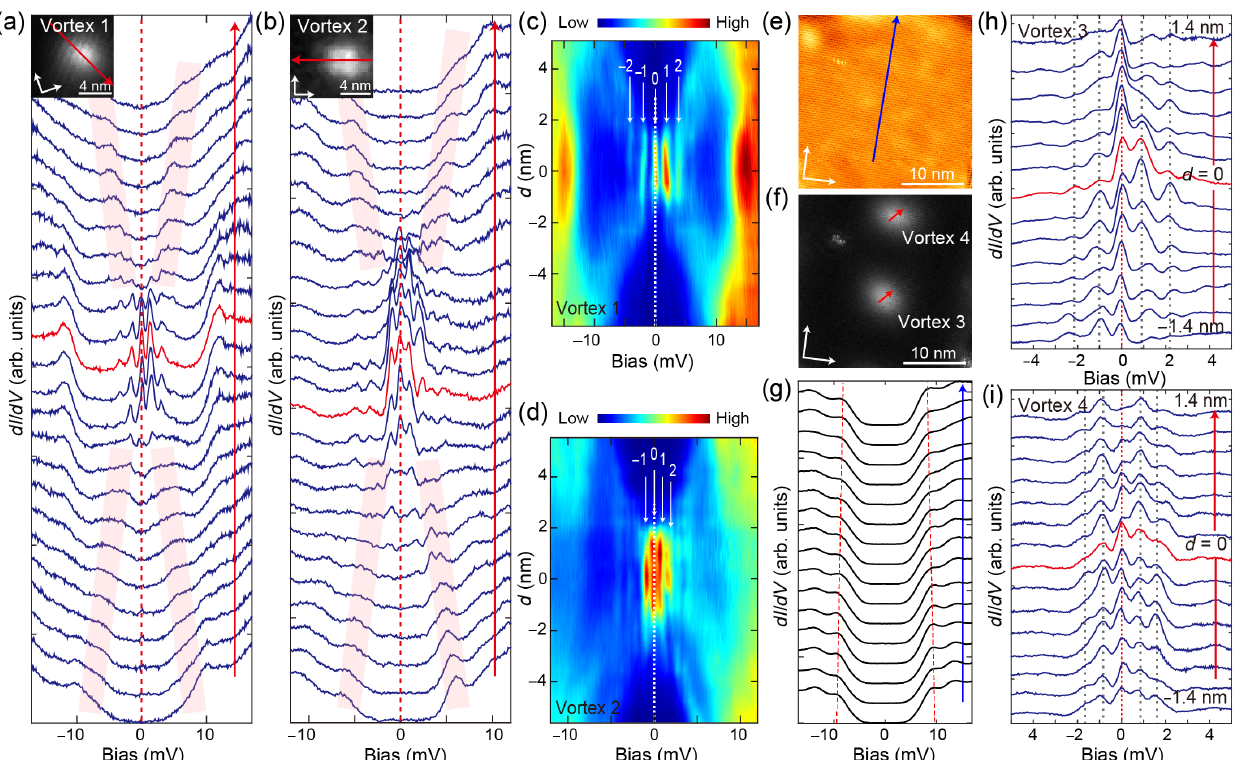
FIG. 3. Bound states in the free vortex cores. (a,b) dI=dV spectra taken across the free vortices 1 and 2, shown in the inset images, respectively (set point: V b ¼ − 17 mV, I ¼ 60 pA). (c,d) Color plots of the spatial dependence of the dI=dV spectra shown in panels (a) and (b), respectively. Dashed lines indicate the zero bias, and arrows indicate the positions of discrete low-energy states. (e,f) Topographic image and vortex mapping ( B ¼ 10 T) of an FeSe surface, respectively. Two free vortices (3 and 4) are observed in this region. (g) dI=dV spectra taken along the blue arrow in panel (e), at T ¼ 4 . 2 K and B ¼ 0 T. Red dashed lines trace the position of inner coherence peaks. (h,i) dI=dV spectra taken along the red arrows in panel (f) across the center of vortices 3 and 4, respectively (set point: V ¼ − 5 mV, I ¼ 60 pA). Dashed lines indicate peak positions at the vortex b